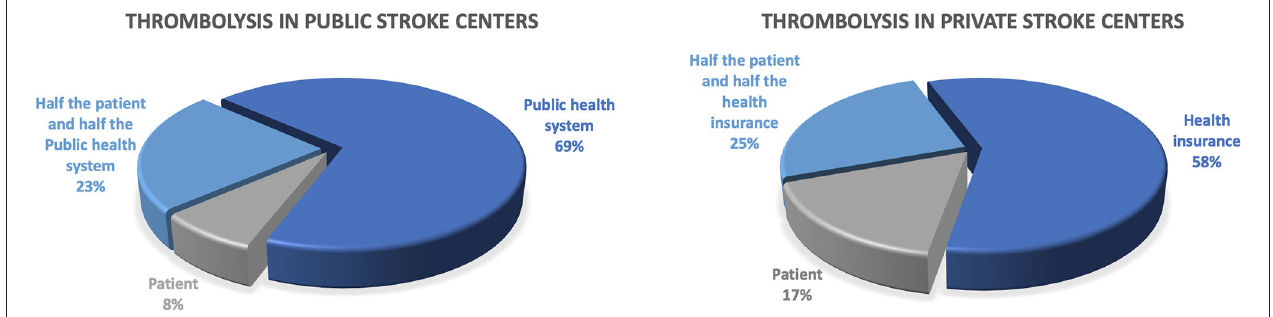
FIGURE 2 | Who pays for intravenous thrombolysis?